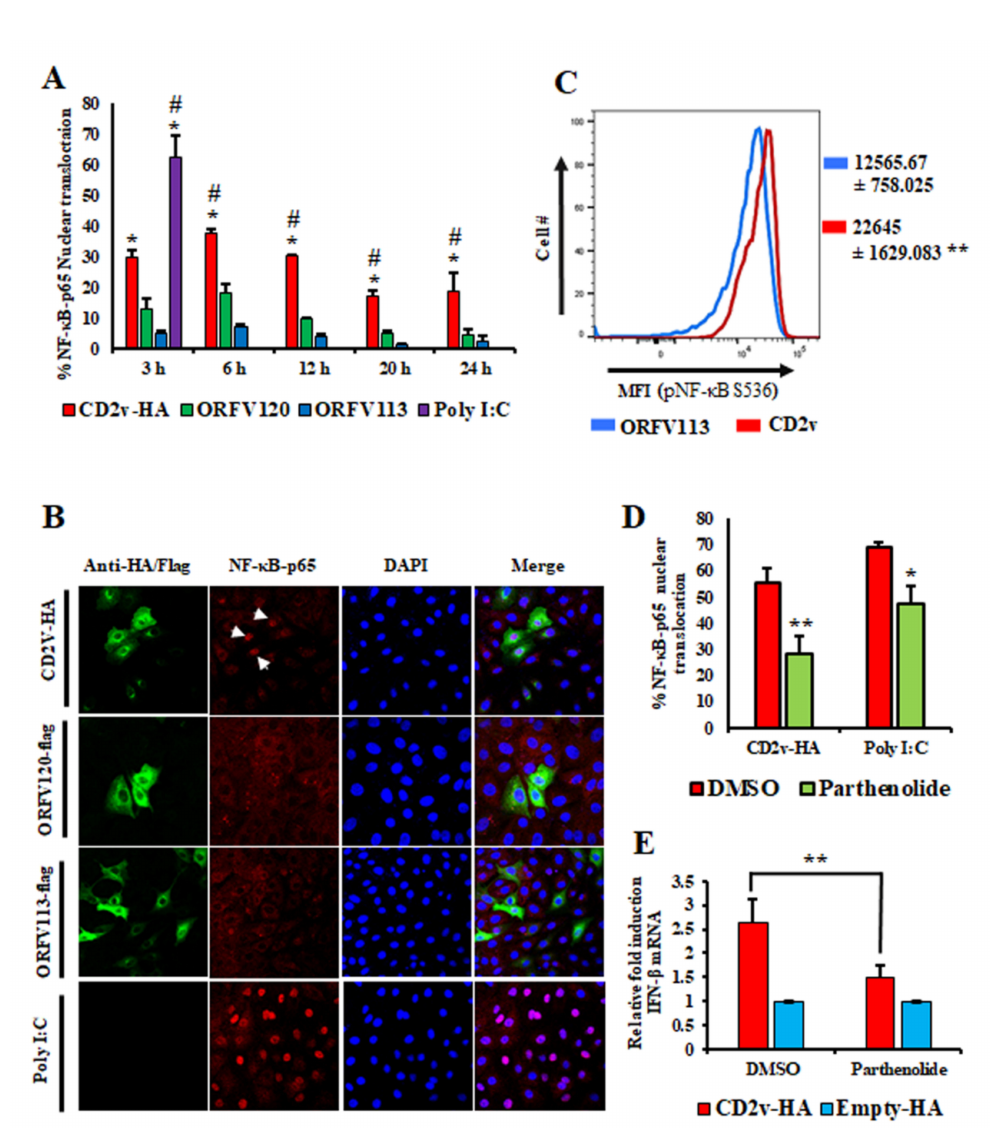
Figure 3. Expression of CD2v in PK15 cells induces IFN- β transcription in a NF- κ B dependent manner. PK15 cells were transfected with pCD2v-HA or controls (pORFV120-Flag, pORFV113-Flag or Poly I:C), processed for immunofluorescence using primary antibodies against HA, Flag or NF- κ B-p65 and secondary antibodies Alexa fluor 488 to detect CD2v, ORFV120 or ORFV113 and Alexa fluor 594 to detect NF- κ B-p65 and counterstained with DAPI. Approximately 100 cells were counted/slide and results are shown as the mean values from three independent experiments. ( A ) Percentage of NF- κ B-p65 nuclear translocation following the different treatments. p -values relative to controls ORFV120 and ORFV113 were 0.056 and 0.009 (3 h); 0.01 and 0.0006 (6 h); 0.019 and 0.02 (12 h); 0.005 and 0.004 (20 h); 0.016 and 0.009 (24 h), respectively. * and # denote statistical significance compared to ORFV120 and ORFV113, respectively. ( B ) Confocal microscopy images showing NF- κ B-p65 nuclear translocation at 3 h pt (arrows). Green, CD2v or ORFV120 or ORFV113; Red, NF- κ B-p65; Blue, DAPI. ( C ) Mean fluorescence intensity (MFI) of phosphorylated NF- κ B (S536) measured by flow cytometry in CD2v and ORFV113 expressing cells at 3 h pt. Results are representative of three independent experiments. p -value relative to ORFV113 is 0.008. ( D ) PK15 cells pretreated with the NF- κ B inhibitor parthenolide (1 µ M) or DMSO (vehicle control) for one hour were transfected with pCD2v-HA or Poly I:C, fixed at 3 h pt and processed for immunofluorescence with antibodies against HA and NF- κ B-p65. Approximately 100 cells were counted/slide and results are shown as mean values from three independent experiments ( p = 0.001). ( E ) PK15 cells treated with parthenolide (1 µ M) or DMSO for one hour were transfected with pCD2v-HA or pEmpty-HA in the presence or absence of parthenolide and IFN- β transcription assessed by RT-PCR at 6 h pt. Fold changes relative to Empty-HA and data are means from four independent experiments ( p = 0.008). (*, p < 0.05; **, p <